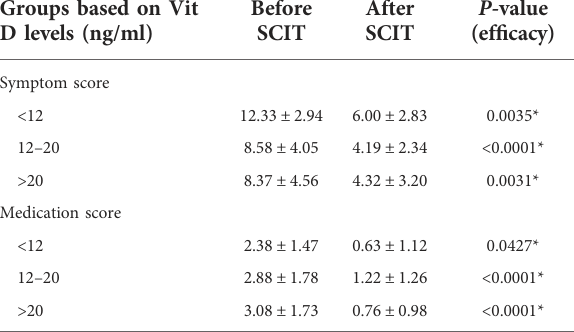
P -value Before After SCIT SCIT